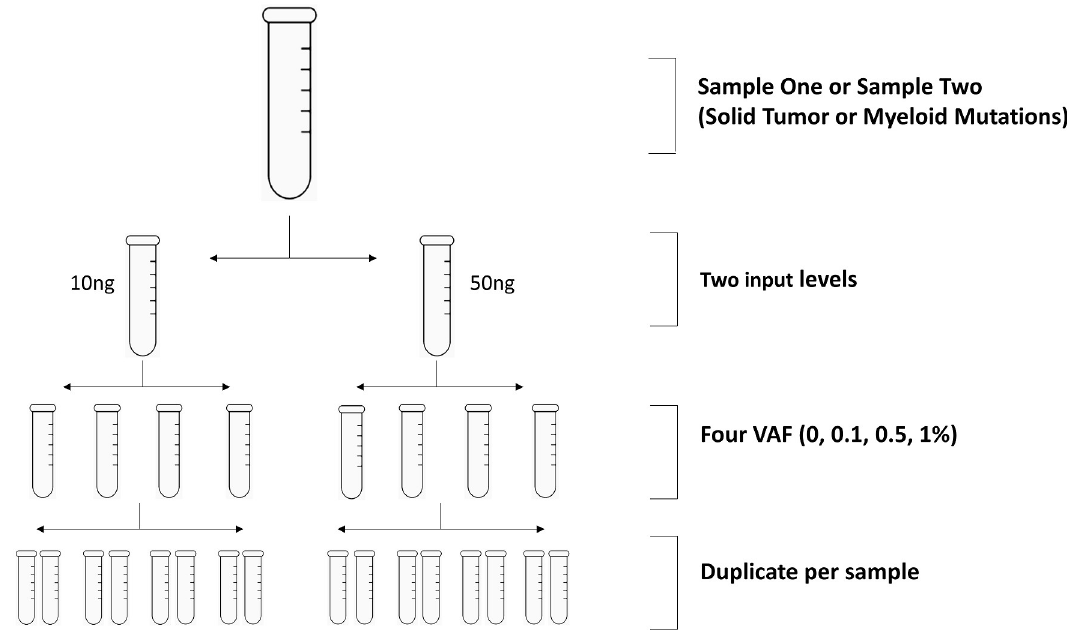
Fig 1. Schematic overview of the cross-platform study. Reference samples: Sample set one or set two tested at 30 ng or 50 ng (per vendor’s protocol specification, Table 1) and 10 ng input respectively. For each input level, four samples carrying mutations at VAF of 0%, 0.125%, 0.5% and 1% respectively were tested in duplicate.